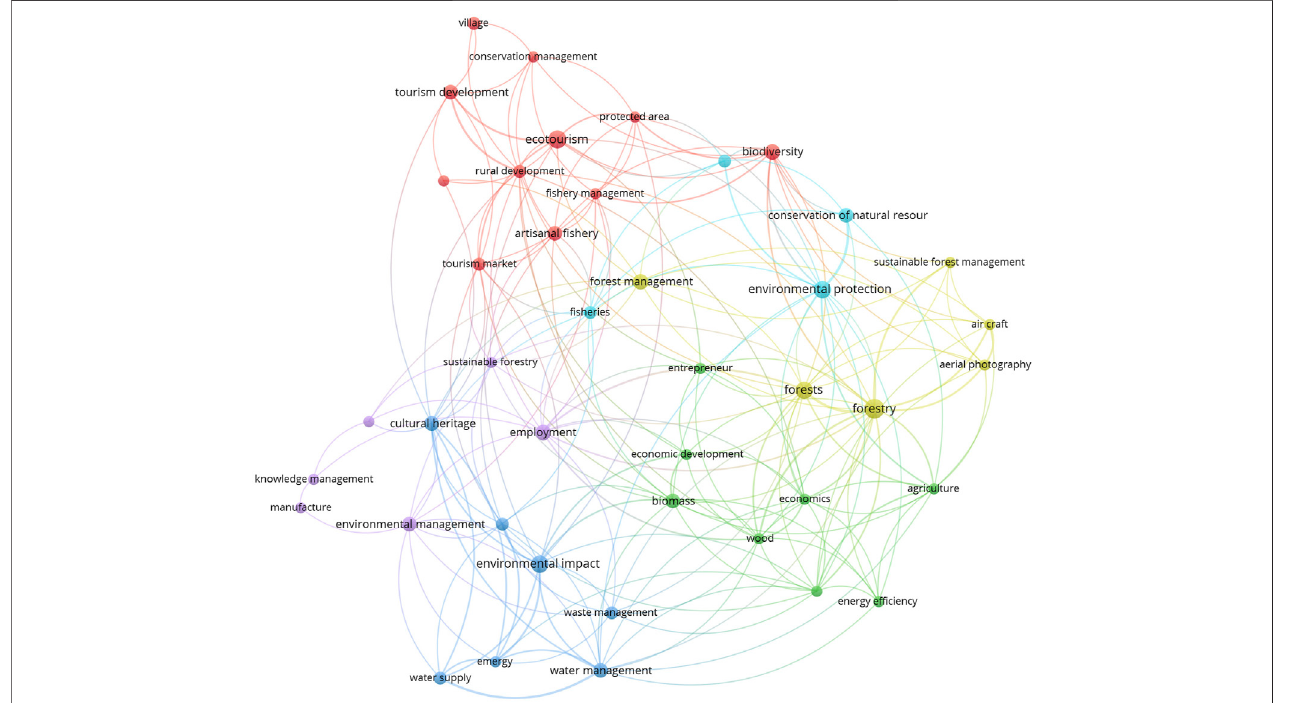
FIGURE 7 | Keyword network on sustainable crafts for the period 2008 – 2014. Source: Authors ’ own.